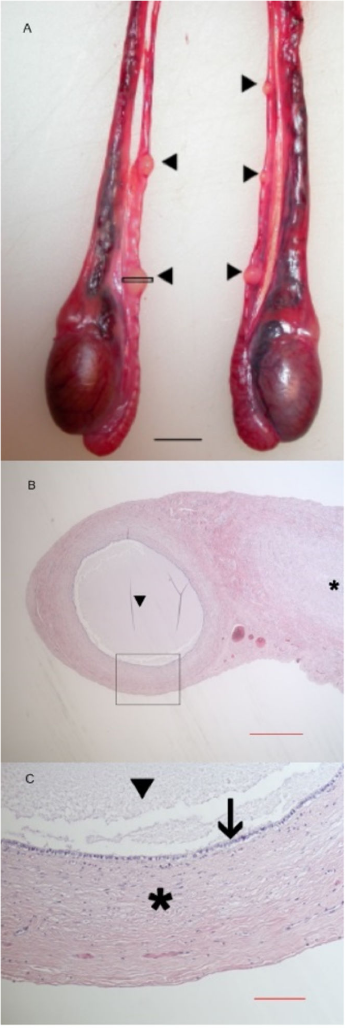
Figure 1. A) Gross anatomical and photomicrographs of Müllerian duct cysts along the spermatic ducts (vasa deferentia) in an otter ( Lutra lutra ). Otter testes, epididymides and funiculi are shown. Arrowheads point to multiple proposed Müllerian duct remnant cysts attached to the spermatic ducts cranial to both the right and left testis. The rectangle indicates were microphotograph in Figure 1b is taken from. Horizontal bar: 1 cm. B) Microphotograph of a paraductular cyst found in an otter ( Lutra lutra ). Overview of typical cyst, transversely cut, with fluid filled lumen (arrow head) and no communication to the adjacent vas deferens (asterisk). H&E stain, horizontal bar in the order of 1,5 mm. The rectangle indicates were microphotograph in Figure 1c is taken from. C) Microphotograph of a paraductular cyst found in an otter ( Lutra lutra ). Higher magnification of the cyst wall, showing the fibrous capsule (asterisk), internally lined by a single layer of cuboidal epithelial cells (arrow). The cyst contains cell-free granular fluid (arrow head). In some cysts these cells are attenuated and flattened. H&E stain, horizontal bar in the order of 300 µm.